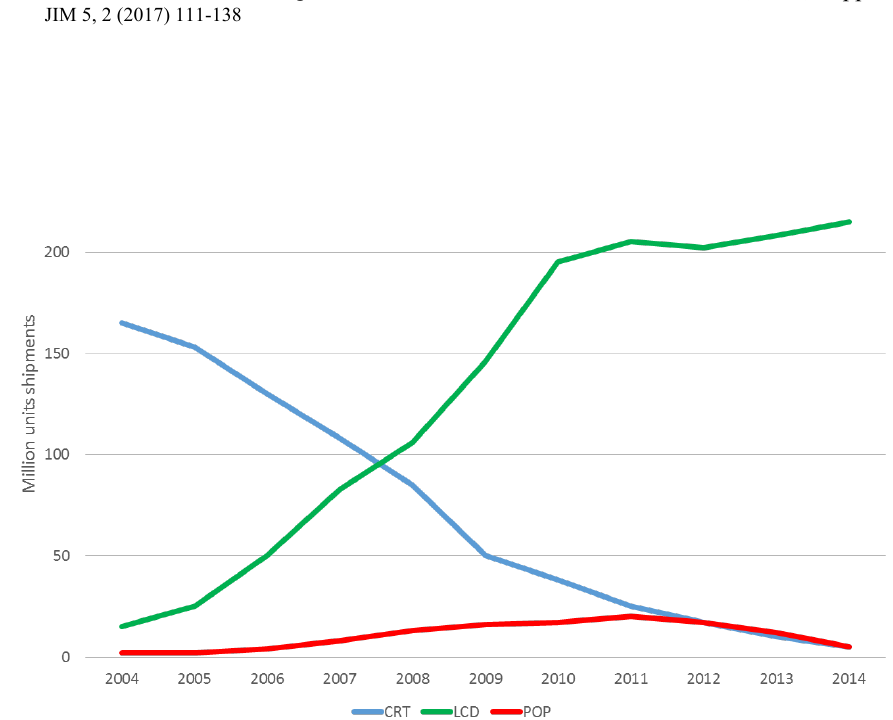
Fig. 1. Sales figures of cathode ray tube (CRT), LCD, and plasma (PDP) monitors